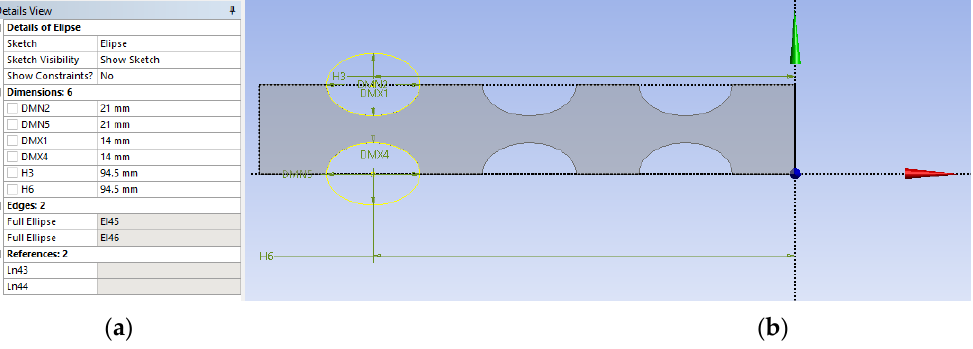
Figure 28. Parametric geometry definition in Design Modeler. ( a ) details view and ( b ) lamella geometry view.